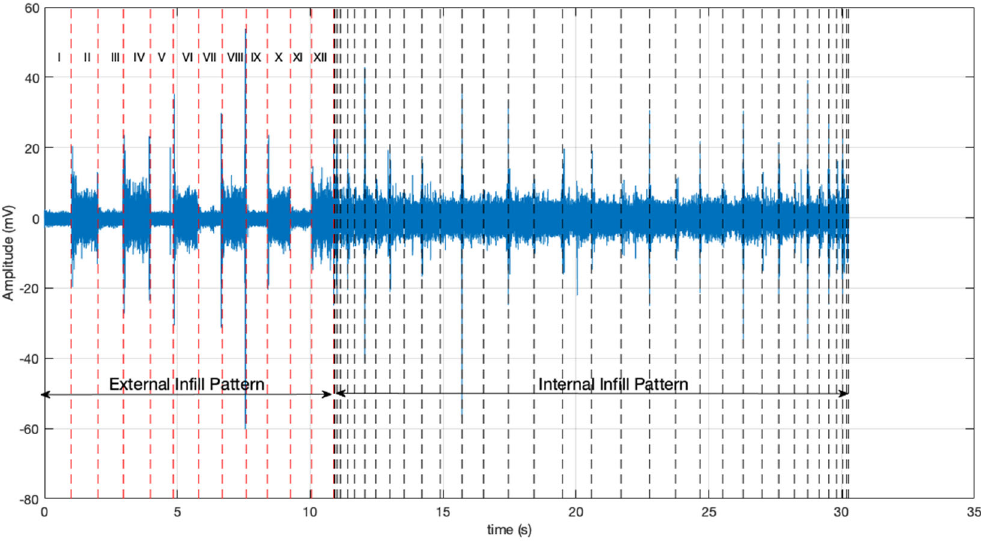
Figure 3. Raw AE signals during the fabrication of the